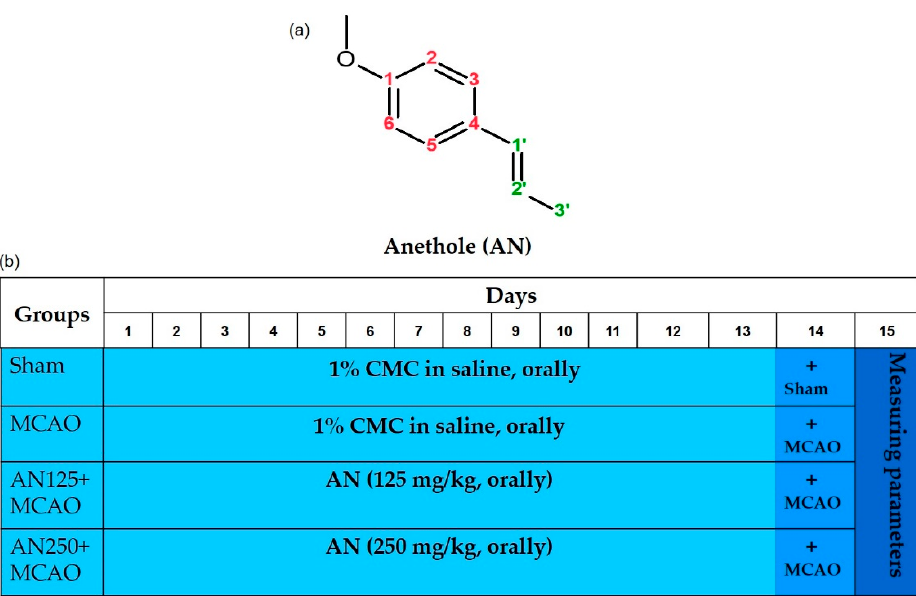
Figure 8. ( a ) Chemical structure of anethole (AN) and ( b ) Experimental design showing the different groups and the respective drug administered. groups and the respective drug